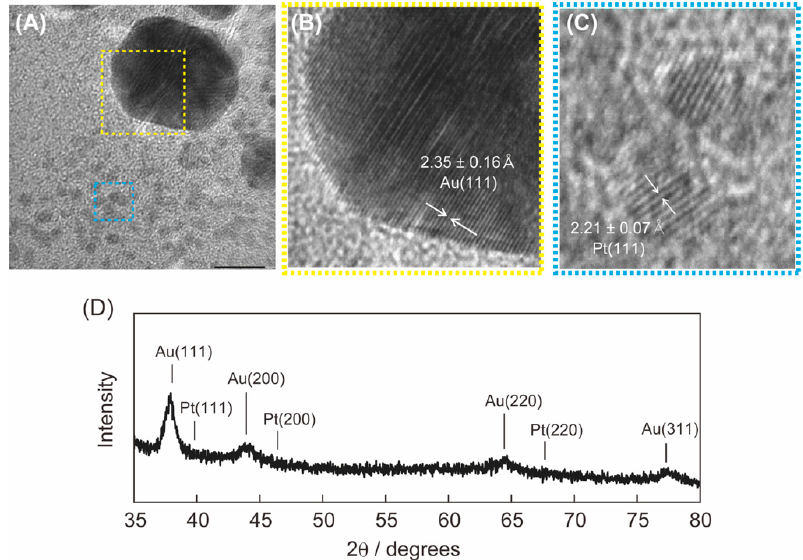
Figure 5. ( A ) TEM image of precipitate obtained from mixture of HAuCl 4 , H 2 PtCl 6 , and RU065 4–8 ( j ) (scale bar = 10 nm). Expanded TEM images of the areas surrounded by ( B ) yellow and ( C ) blue squares in panel A. ( D ) X-ray diffraction pattern for precipitate from mixture of HAuCl 4 , H 2 PtCl 6 , and RU065 4–8 ( j ). Diffraction peaks were assigned based on JCPDS data for face-centered cubic (fcc) structures for each element. Peptide = 2.0 × 10 − 4 M, HAuCl 4 = H 2 PtCl 6 = 5.0 × 10 − 5 M in water. Reactions were conducted at 40 ° C for 24 h in the dark.